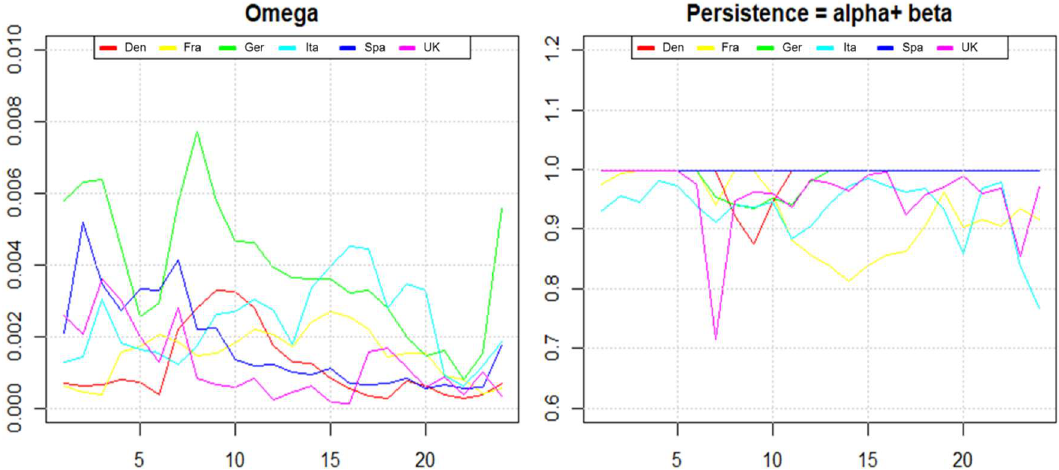
10 am. Germany is similar to Denmark. Countries France, UK, and Italy have values less than 1 for most hours. When the sum 𝛼(cid:3548) + 𝛽(cid:4632) is 1 the GARCH model becomes iGARCH.